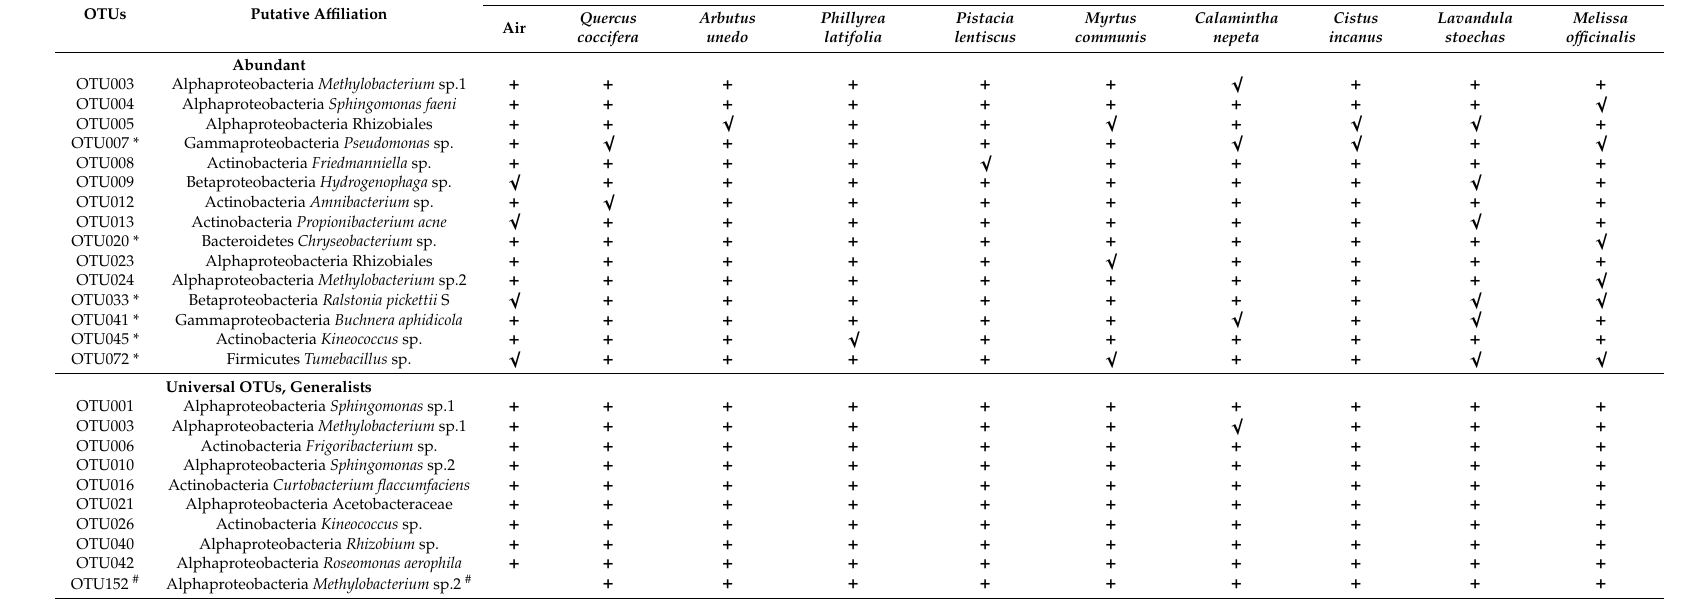
Table 5. Abundant (making > 1% of the total number of reads) and universal OTUs (present in all phyllosphere habitats) that are assessed as generalists according to Levins’ index and their closest relatives. The symbol ‘ + ’ represents presence in the sample, whereas ‘ Among the abundant OTUs, marked with * are the specialists according to Levins’ index. For further details about the closest relatives of the OTUs detected, see Supplement Table